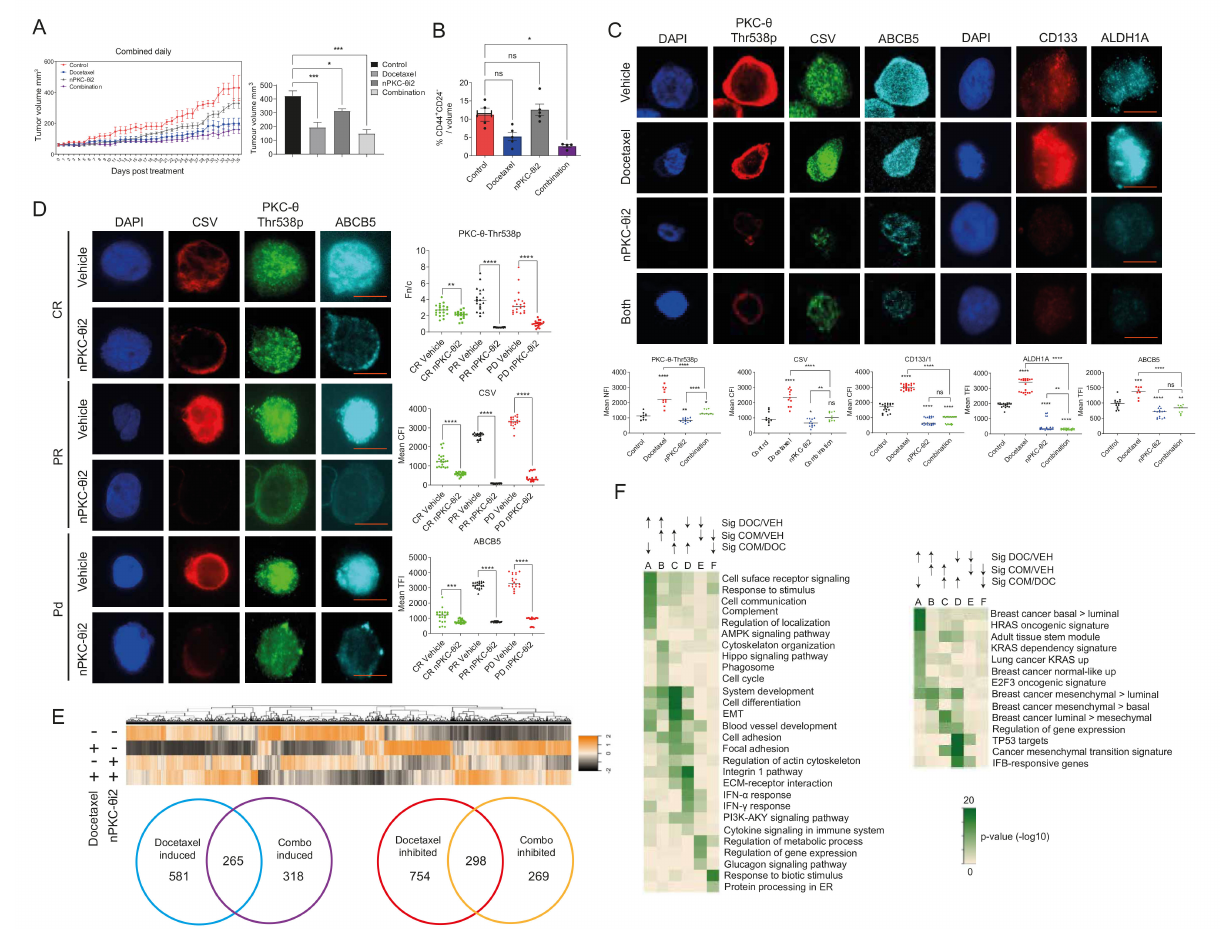
Figure 5. Impact of the novel PKC- θ inhibitor on tumors in a TNBC xenograft model and CTCs from melanoma patients. ( A ) Tumor volume in MDA-MB-231 mouse-bearing tumors treated with vehicle control, docetaxel (4 mg/kg), nPKC- θ i2 (40 mg/kg), or both (docetaxel given 3 times, 1 week apart and nPKC- θ i2 given daily for 5 weeks). Tumor volumes were measured daily for each mouse. Each data point represents a single mouse ( n = 4 mice per group). ( B ) Percent CD44 hi /CD24 lo CSC cells in total tumor in the MDA-MB-231 mouse model. ( C ) Immunofluorescence microscopy of tumor cells from MDA-MB-231 TNBC mice treated with nPKC- θ i2 in combination with docetaxel showing that nPKC- θ i2 inhibits the fluorescence intensity of PKC- θ and key stem cell niche markers CD133, ALDH1A, and ABCB5 and mesenchymal marker CSV. ( D ) CTCs were isolated from melanoma patient liquid biopsies (CR = complete response, PR = partial response, PD = progressive disease) and were pre-clinically treated with either vehicle control or nPKC- θ i2. Samples were fixed and immunofluorescence microscopy performed on these cells with primary antibodies targeting CSV, PKC- θ , and ABCB5. Representative images for each dataset are shown. Graph represents the TCFI values for CSV, NFI for PKC- θ , and TFI for ABCB5 measured using ImageJ to select the nucleus minus background ( n ≥ 20 cells/sample). ( E ) Heatmap of tumor transcriptomes using all significant genes together with a Venn diagram comparison of genes induced by docetaxel/combination therapy or inhibited by docetaxel/combination therapy relative to vehicle control and the overlap between these groups. ( F ) Heat map of enriched pathways in gene sets induced relative to vehicle control with comparison of geneset pathways induced by docetaxel (DOC) or docetaxel and nPKC- θ i2 (COM). Statistical significance is denoted by ns (not significant), * p ≤ 0.05, ** p ≤ 0.005, *** p ≤ 0.0005, and **** p ≤